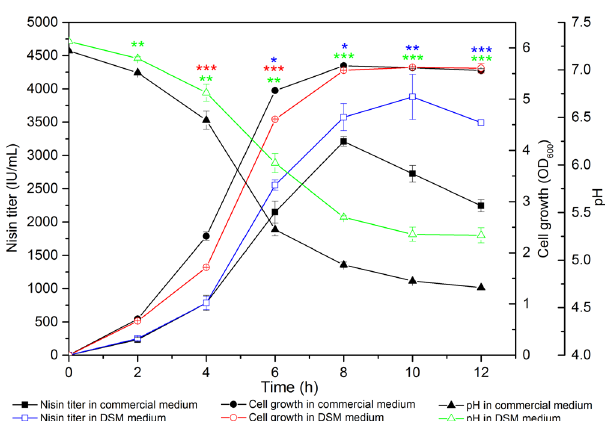
Figure 3. Time profile of nisin titer (square), cell density (circle) and pH (triangle) of L . lactis F44 cultured in DSM medium (hollow symbols) and commercial medium (solid symbols). Average data of triplicate experiments were presented. Error bars represent standard deviations from three parallel replicates. The data were analyzed by One-way ANOVA. Statistically significant differences between DSM medium groups and commercial medium groups were indicated by for * p < 0.05 for ** p < 0.01 and for *** p <